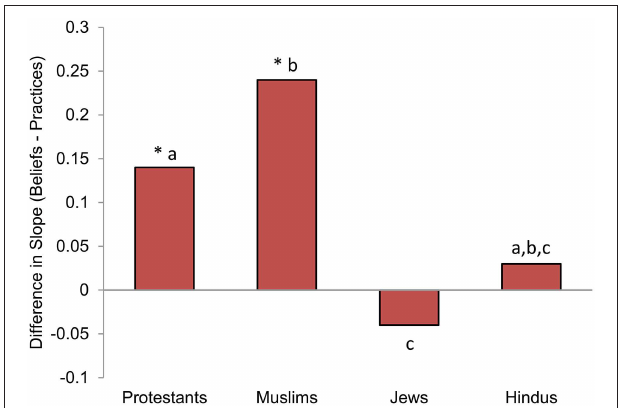
FIGURE 2 | Differences in slopes for beliefs predicting religiosity and practices predicting religiosity, by religious group. Asterisks indicate that the difference in slopes is greater than zero. Different subscripts indicate that these bars differ from each other at the p < 0 . 05 level.